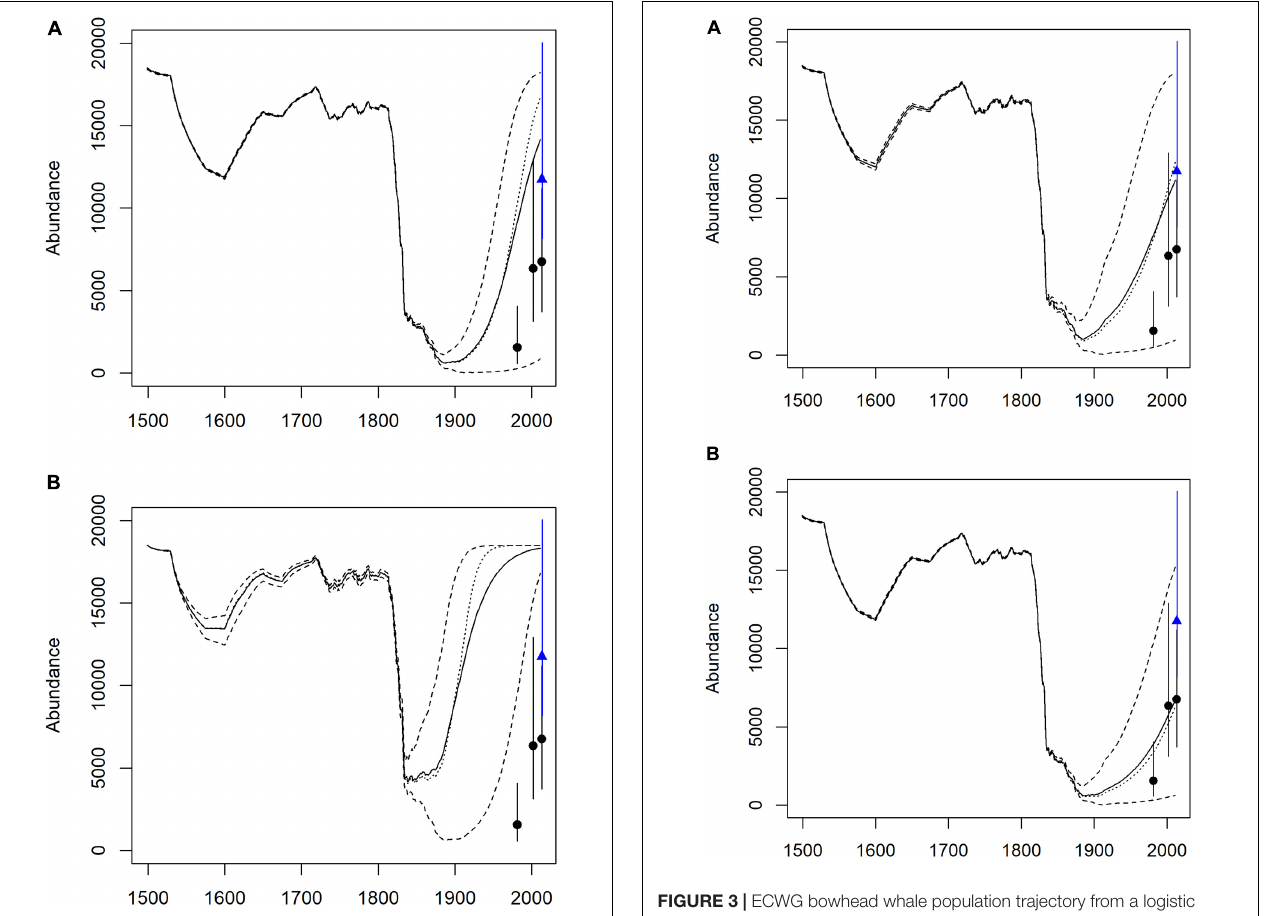
FIGURE 2 | Mean (solid line) and 95% confidence intervals (dashed line) of ECWG bowhead whale population trajectory estimated from 10,000 Monte Carlo simulations of a logistic population growth model and removals estimated using historical catch data and a struck and lost correction factor. Carrying capacity (K), defined as the starting population size prior to exploitation, was set at 18,500 animals. Models included a uniform distribution for struck and lost correction that ranged from 1.10 to 1.20, and a uniform distribution for R max that ranged from 0.035 to 0.045. Recent population estimates are shown for comparison, from aerial surveys (circle symbols) in 1981 (Koski et al., 2006), 2002 (IWC, 2009b) and 2013 (Doniol-Valcroze et al., 2020) and from genetic Capture-Mark-Recapture analysis (2013), blue triangle symbol (Frasier et al., 2020)]. Upper panel (A) is model results that include zero values and lower panel (B) is model results that exclude zero population abundance values.